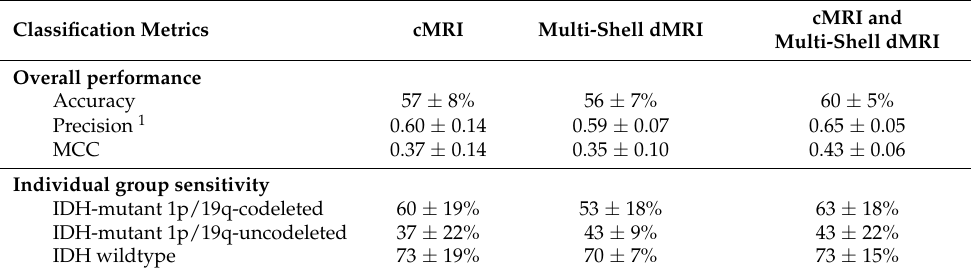
Table 6. Subtype classification performances in adult-type gliomas (WHO CNS5). Classification